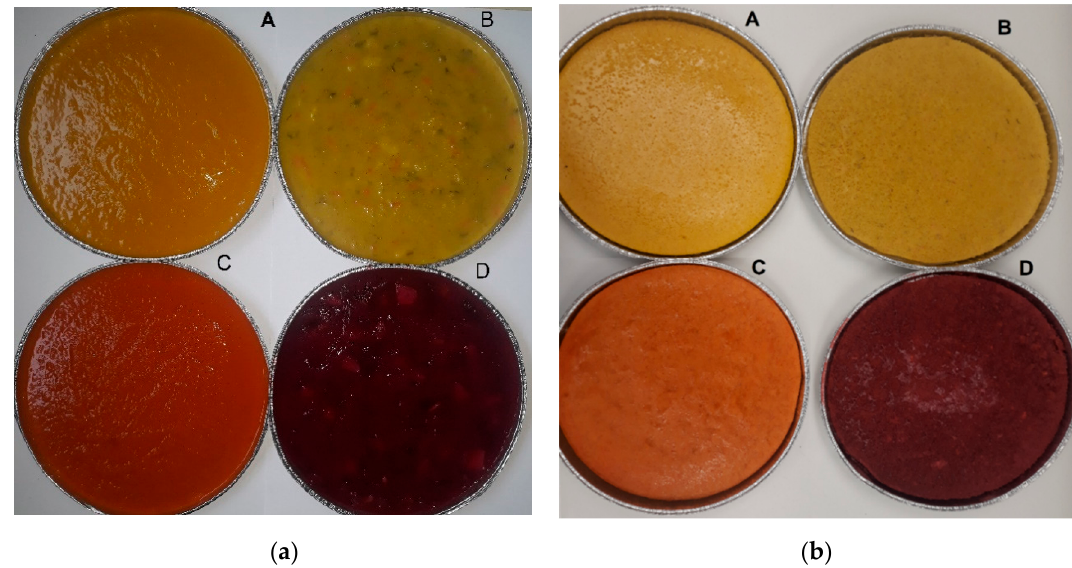
Figure 3. The pumpkin (A), cucumber (B), tomato (C), and beetroot (D) of fresh ( a ) and freeze-dried ( b ) soups. Table 3. Concentration of the main solid compounds of different freeze-dried soups.